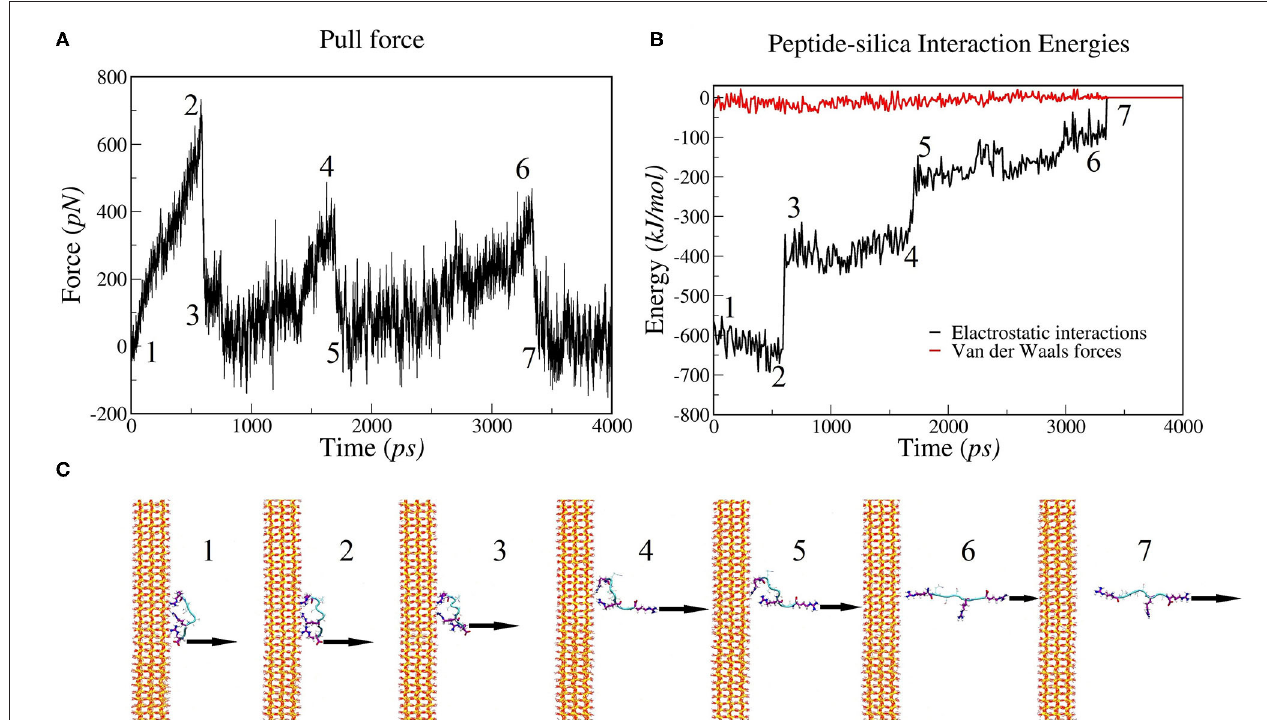
FIGURE 6 | MD simulations of pulling SB7 (RQSSRGR) away from silica surface. (A) Force changes over time (constant pulling speed of 1 nm/ns); (B) Energy changes over time. (C) Snapshots of peptide-silica structure. The numbers labeled on (A,B) correspond the time of the snapshots in (C) . 1: The structure before pulling; 2 and 3: the structure before and after the R7 residue unbinding, respectively; 4 and 5: the structure before and after the R5 residue unbinding; 6 and 7: the structure before and after the R1 residue